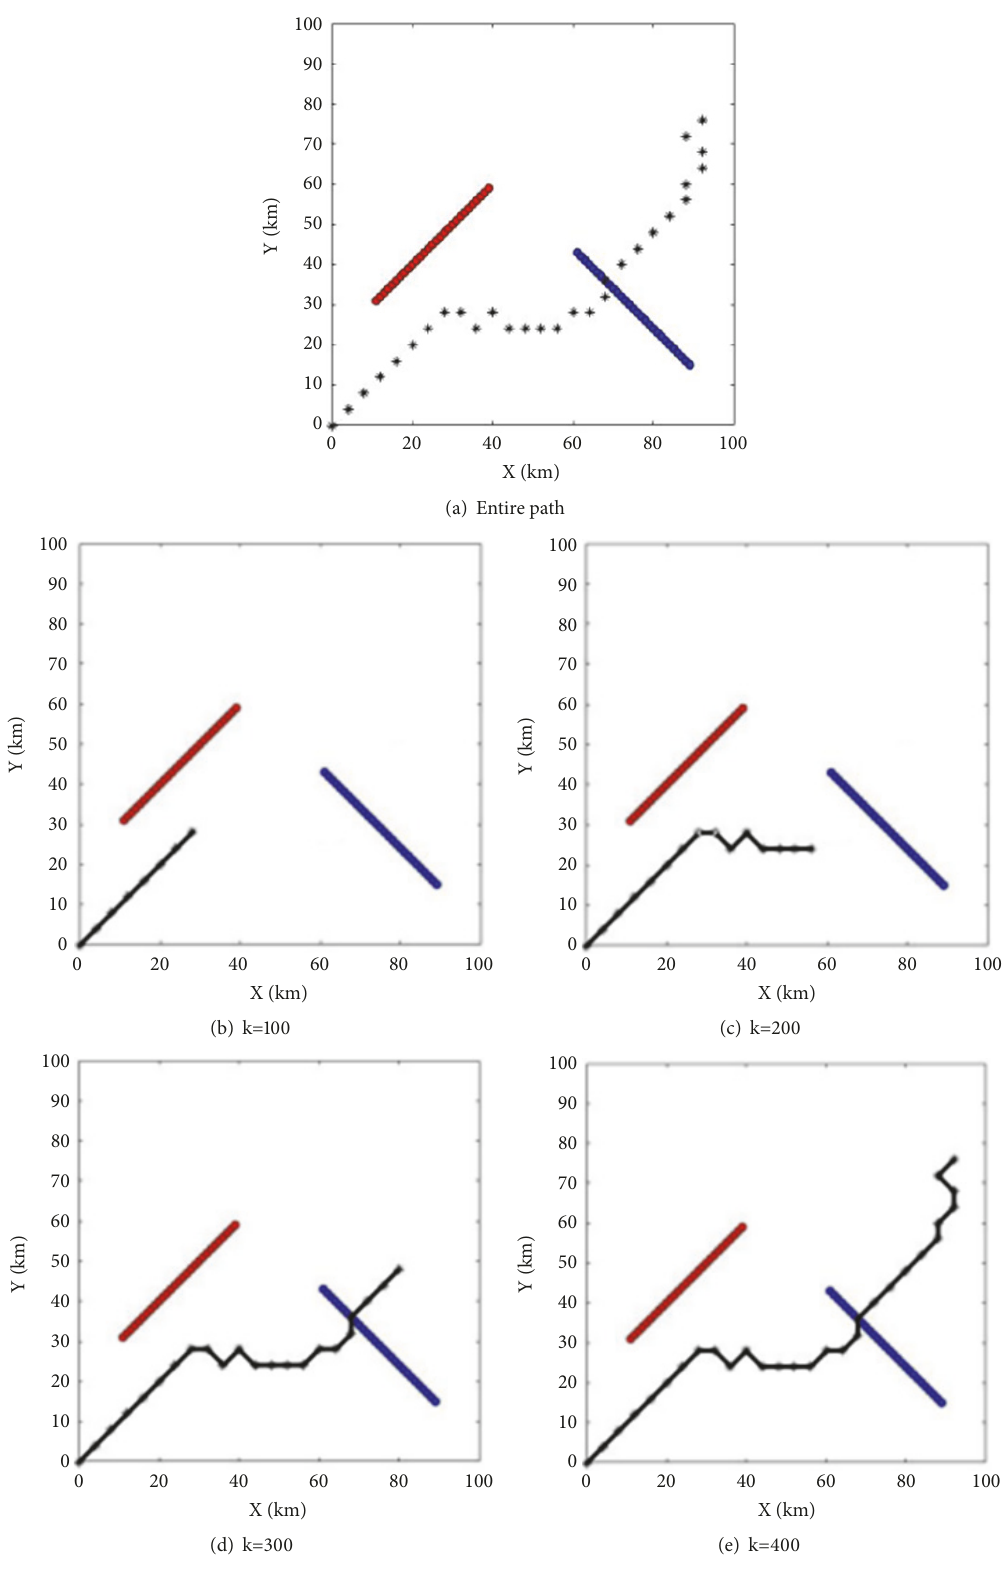
Figure 15: UAV path planning in another environment based on ACO algorithm. And there are only mobile threats where (a) is an entire path and (b) to (e) are paths with iterations = 100, 200, 300,